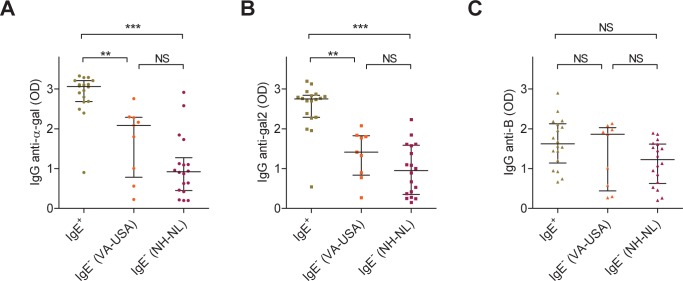
Individuals positive for IgE anti-α-gal make significantly more IgG anti-α-gal.IgG antibody responses to A) α-gal, B) gal2, and C) B antigens in individuals who are positive for IgE anti-α-gal (IgE+), and individuals from both Virginia, USA, and North-Holland, The Netherlands, who are negative for IgE anti-α-gal (IgE–), as measured in ELISA (1 µl serum/test). All subjects are B–. IgE+ individuals make significantly more IgG anti-α-gal and anti-gal2, but not anti-B (Kruskal-Wallis with Dunn’s multiple comparison test). NS: not significant.